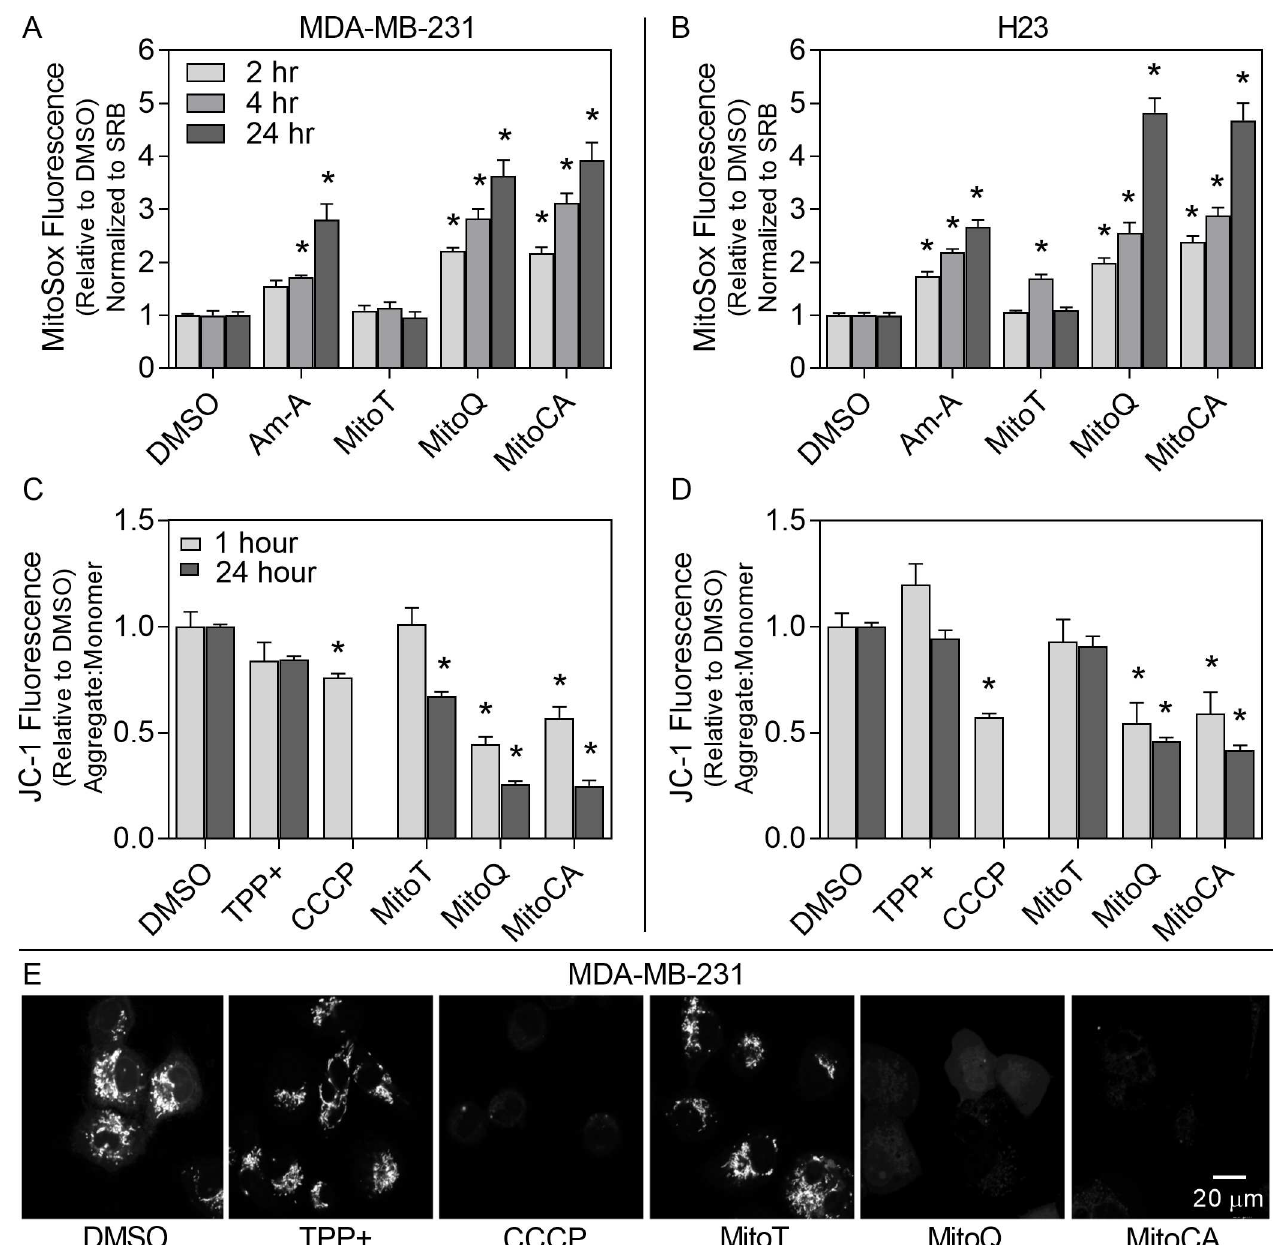
Fig 1. Mitochondrial superoxide production and MMP. MDA-MB-231 (A,C,E) and H23 (B,D) cell lines were exposedto either DMSO (0.02%), TPP + MitoT, MitoQ or MitoCA at 2 μ M, Antimycin A (Am-A) at 40 μ Mor CCCP at 50 μ Mfor 1 or 2 (light gray), 4 (gray) or 24 (dark gray) hours. In A-B, superoxide levels were assessed using MitoSOX normalized to total protein determined by the SRB assay. In C-D, MMP was assessedusing the JC-1 assay by calculatingthe ratio of aggregates (590nm) to monomers (540nm). Bars representthe averagenormalized fluorescence per cell in at least two independent experiments (n = 4–10) relativeto the DMSO control +/-1 SEM. Asterisks denote statistical significance at p < 0.05relative to the respectiveDMSO control at each time. TMRM imaging(E) was used to confirm changesin MMP in MDA-MB-231 cells after 1 hour drug exposure(as in C-D). Scale bar is 20 μ